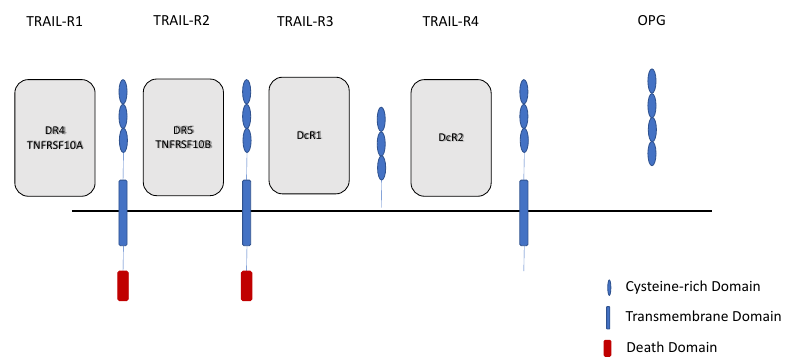
Figure 1. TRAIL receptors and their alternative names. TRAIL-R1 is also known as DR4 (death receptor 4) and TNFRSF10A (tumor necrosis factor receptor superfamily member 10A); TRAIL-R2 is also known as DR5 (death receptor 5) and TNFRSF10B (tumor necrosis factor receptor superfamily member 10B); TRAIL-R3 is also known as DcR1 (decoy receptor 1), TRAIL-R4 is also known as DcR2 (decoy receptor 2); OPG — osteoprotegerin (soluble decoy receptor) .